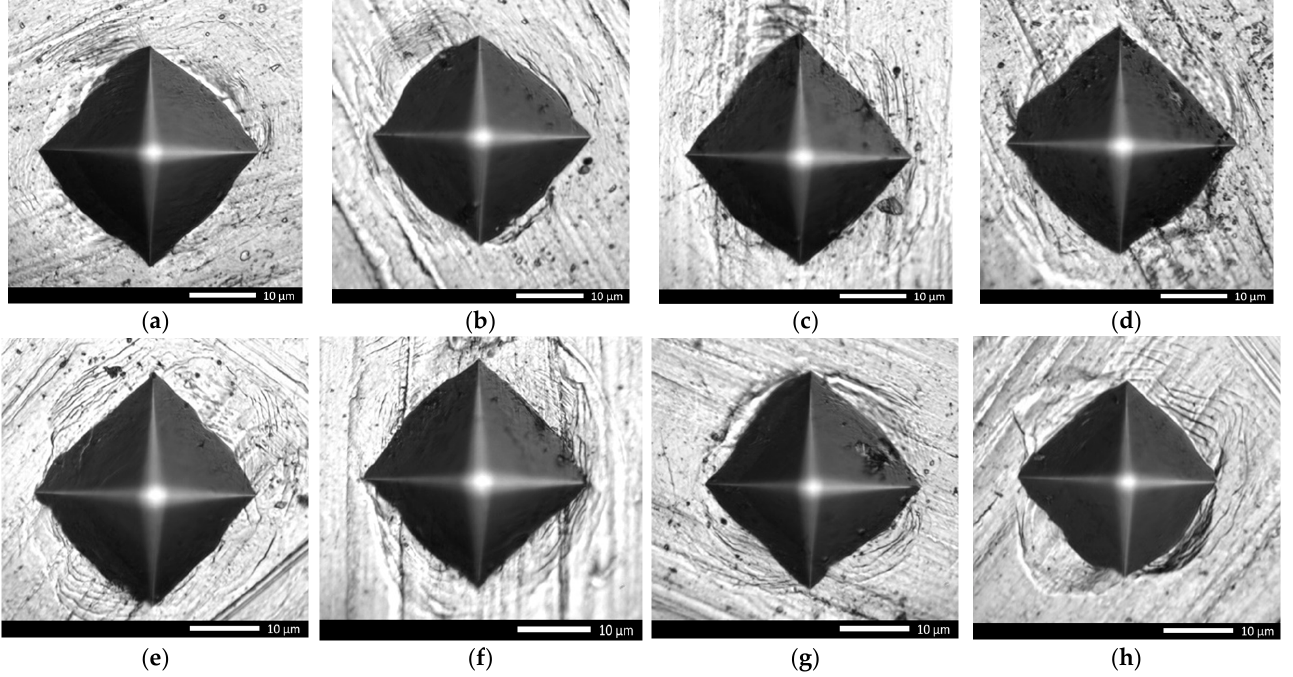
Figure 7. Image of indenter prints in NbTiVZr high-entropy alloy, made using a microhardness tester depending on the irradiation fluence: ( a ) initial sample; ( b ) 10 10 ion/cm 2 ; ( c ) 10 11 ion/cm 2 ; ( d ) 10 12 ion/cm 2 ; ( e ) 5 × 10 12 ion/cm 2 ; ( f ) 10 13 ion/cm 2 ; ( g ) 10 14 ion/cm 2 ; ( h ) 10 15 ion/cm 2